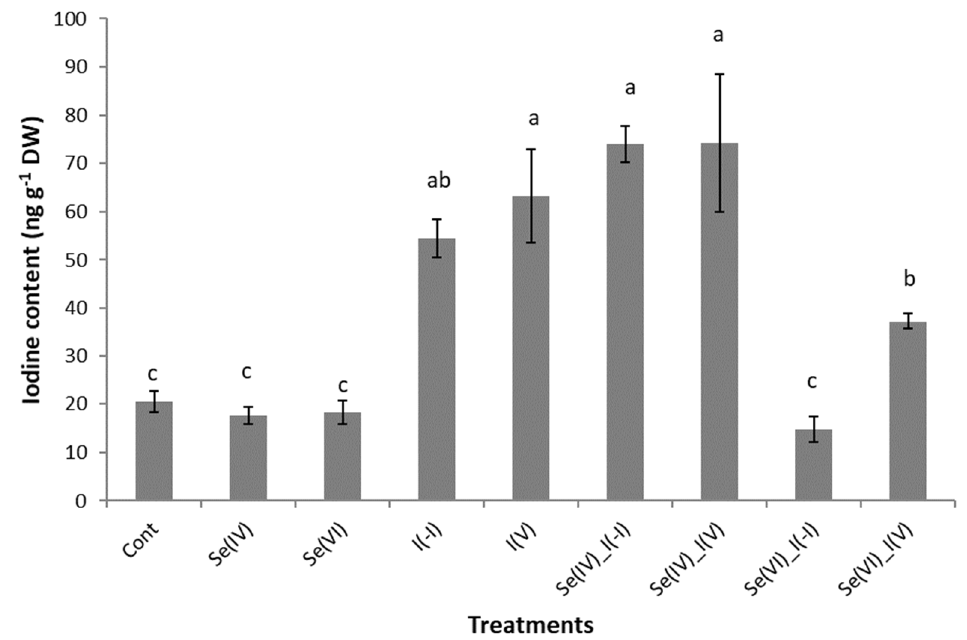
Figure 2. Iodine content in chicory leaves following the indicated foliar spraying. Data are means ± SE. Means followed by different superscript letters are significantly different at p <0.05 (n = 5).